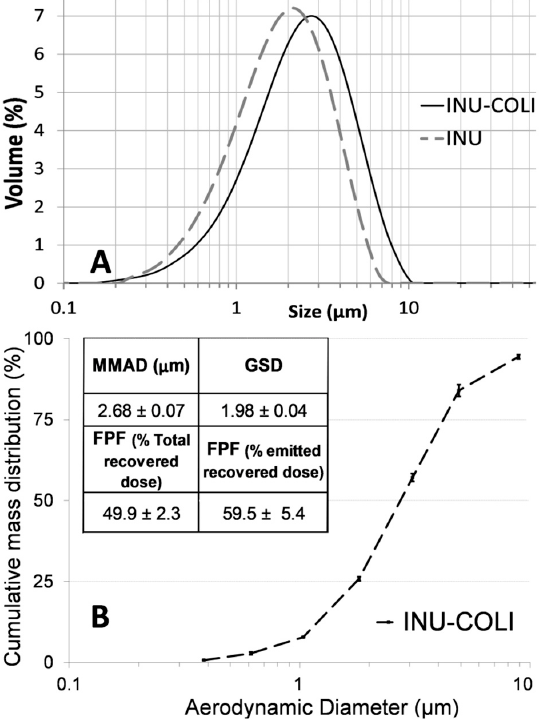
Figure 3. ( A ) Geometric particle size distribution determined by laser diffraction (n = 3). ( B ) Cumulative fraction of the mass of INU-COLI collected on the Next Generation Impactor (NGI) stages versus the effective cut-off diameter of the stages (n = 3).